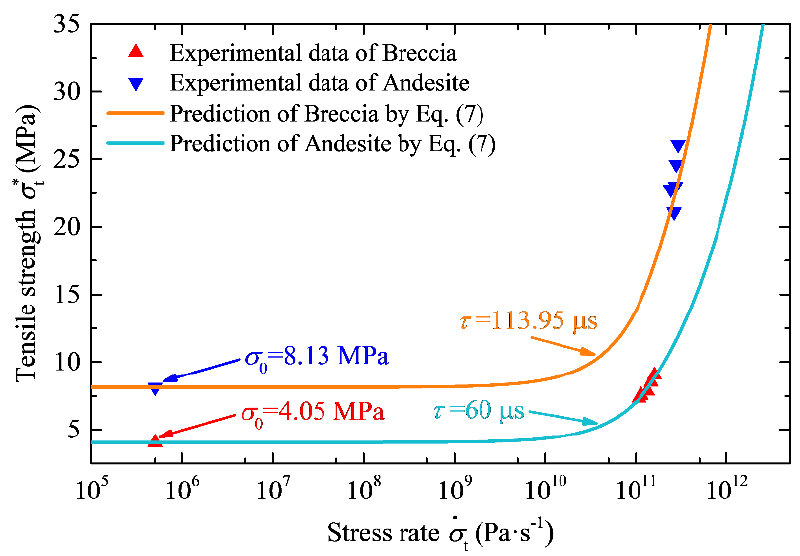
Figure 5. Tensile strengths of Breccia and Andesite versus stress rate.